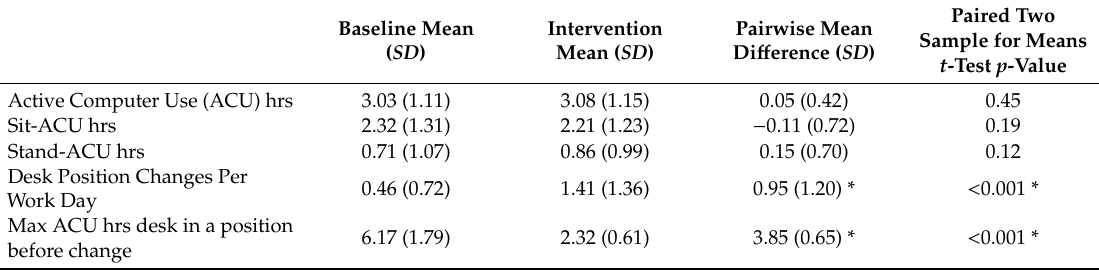
Table 2. Overall group means and pairwise comparisons.